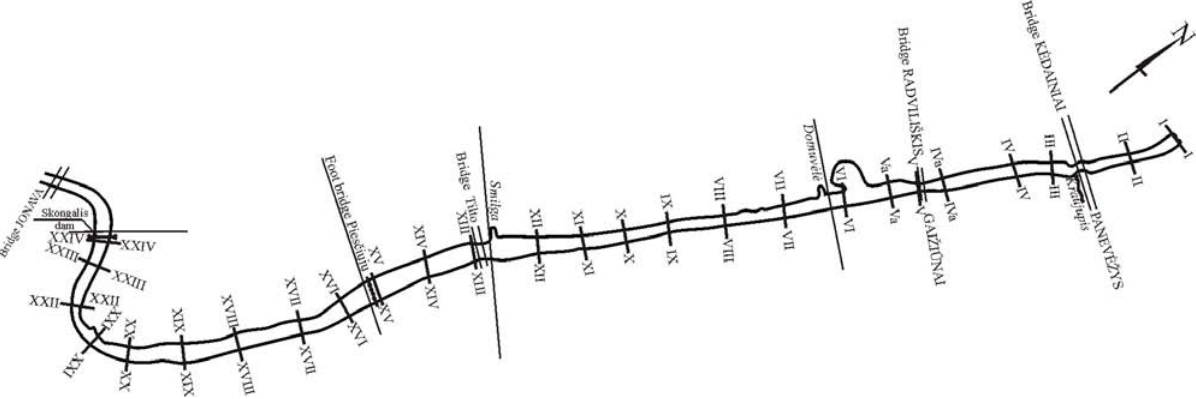
Fig. 2. Distribution scheme of cross-sections in modelled section of the Nev ė žis River